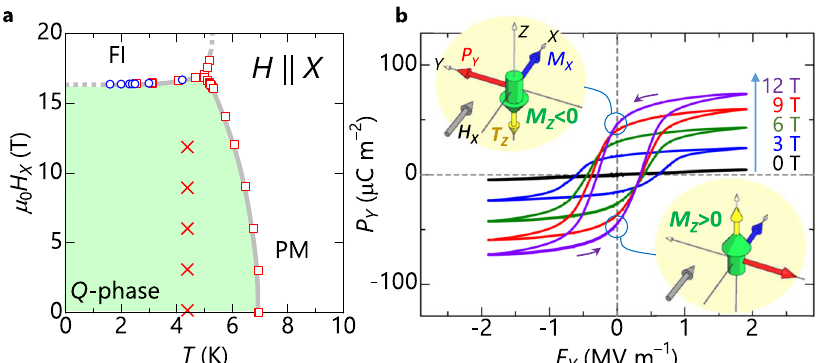
Fig. 3 Fundamental magnetoelectric properties of Pb(TiO)Cu 4 (PO 4 ) 4 . a Temperature ( T ) versus magnetic fi eld ( H ) phase diagram for H applied along the X axis ( H X ). The Q -phase represents an antiferromagnetic phase with a magnetic quadrupole order, which is a subject in this work. FI and PM denote fi eld-induced and paramagnetic phases, respectively. b Ferroelectric hysteresis loops at temperature ( T ) of 4.2 K measured in H X whose strength is varied between 0 to 12 T with a 3 T interval. The electric polarization along the Y axis ( P Y ) was measured as a function of the electric fi eld along the Y axis ( E Y ). The positions of the measurement temperature and H X are marked by red crosses in the phase diagram in a . Shown in the insets of b are the geometrical con fi gurations of H X , P Y , M X , T Z , and M Z for bistable states at E Y = 0. Here, M X and M Z are the magnetization along the X and Z axes, respectively, and T Z is the toroidal moment along the Z whose in-plane ( Z -plane) and the out-of-plane spin components that φ > 0 and φ < 0 represent the C − and C + crystals, respec- form two-in two-out and up-down – up-down arrangements, tively. According to the structural analysis at room temperature, respectively (see Fig. 2d). The magnetic point group of the | φ | is estimated to be 4.5° 20 . antiferromagnetic state is 4 ′ 22 ′ , which breaks both space- PbTCPO undergoes an antiferromagnetic transition at T N inversion and time-reversal symmetries, and allows for an ordering ( = 7.0 K at 0 T) 20 , as indicated by the magnetic phase diagram of Q XY and the corresponding linear ME effect with fi nite α YX in Fig. 3a. In the antiferromagnetic phase, the four Cu spins of each square cupola exhibit a noncoplanar arrangement (Fig. 2a), ( = α YX ). As depicted in Fig. 2d – g, each chiral crystal can possess a